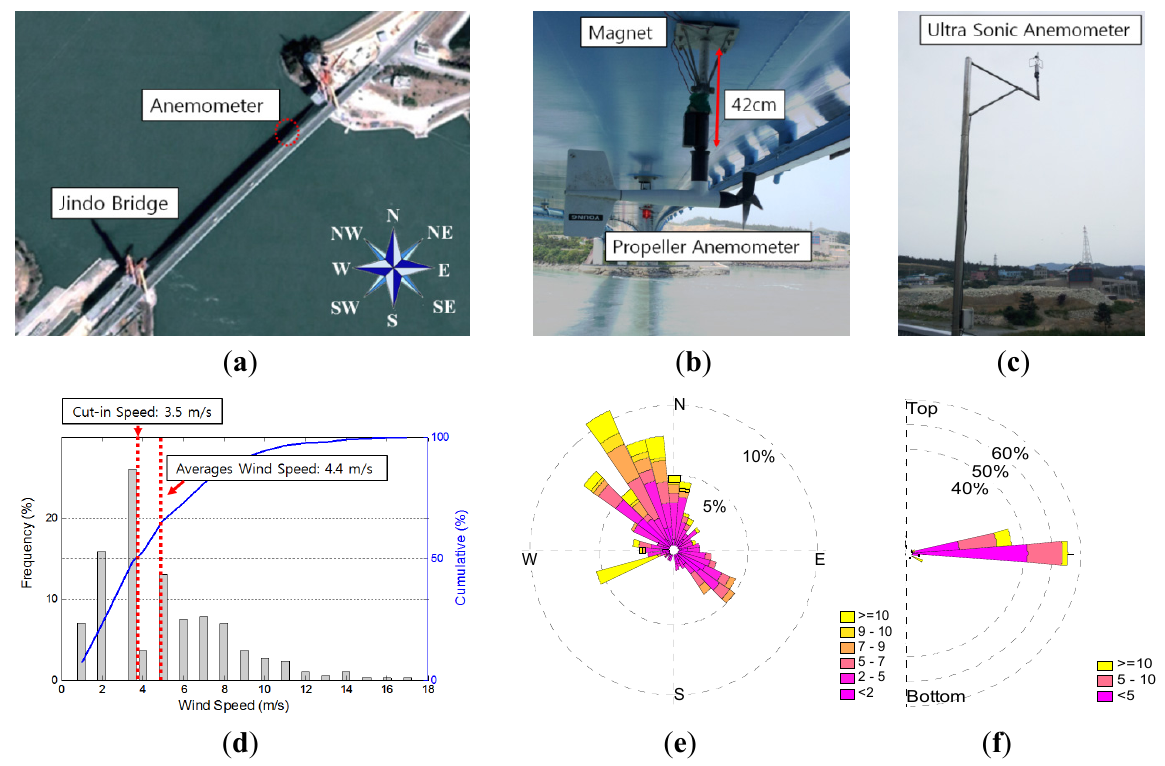
Figure 3. Wind record measured at the Jindo Bridge: ( a ) overview of the Jindo Bridge; ( b ) anemometer at the bottom of the girder; ( c ) anemometer at the top of the girder; ( d ) wind distribution; ( e ) wind rose in the horizontal direction; ( f ) wind rose in the vertical direction.